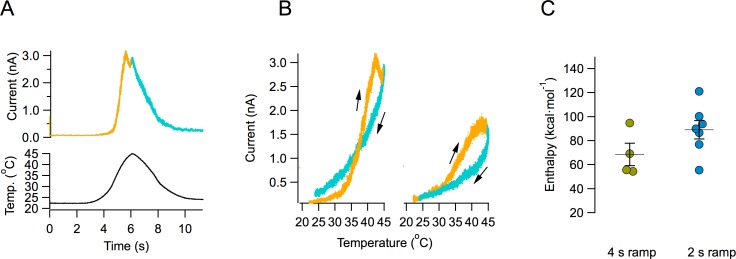
Hysteresis is present and identical in longer temperature ramps.(A) Temperature ramps lasting 8 s (4 s up and 4 s down) elicit currents that show asymmetric up and down components (upper panel). (B) The temperature-dependence of the activation and deactivation of TRPV1 in longer ramps is identical to that observed in shorter ramps and the loss of current is present with subsequent application of activation ramps. (C) Enthalpy associated with activation is indistinguishable for currents activated by 4 s (up) or 2 s (up) ramps.